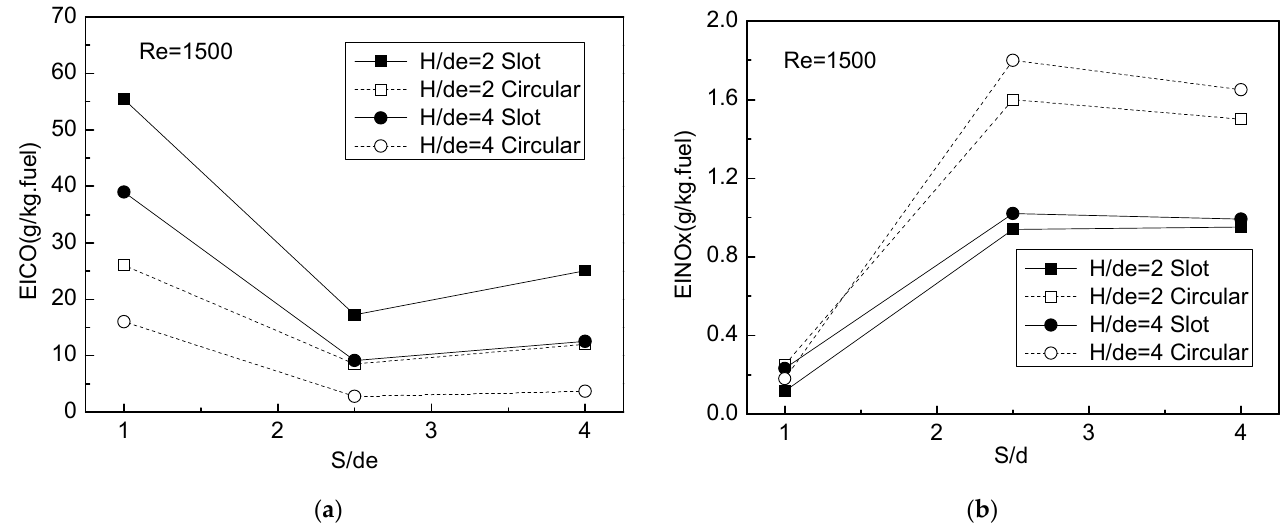
Figure 10. Comparison of EICO ( a ) and EINO x ( b ) of slot and round LPG flame array at Re = 1500.